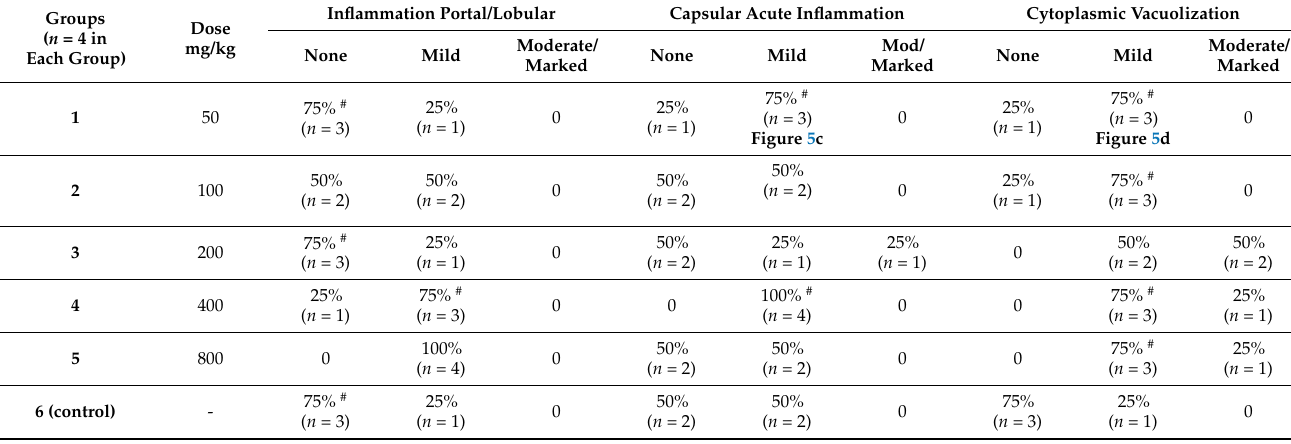
Table 6. Extent of portal, lobular, and capsular inflammation and cytoplasmic vacuolization in hepatic tissue in acute toxicity study ( n = 24).